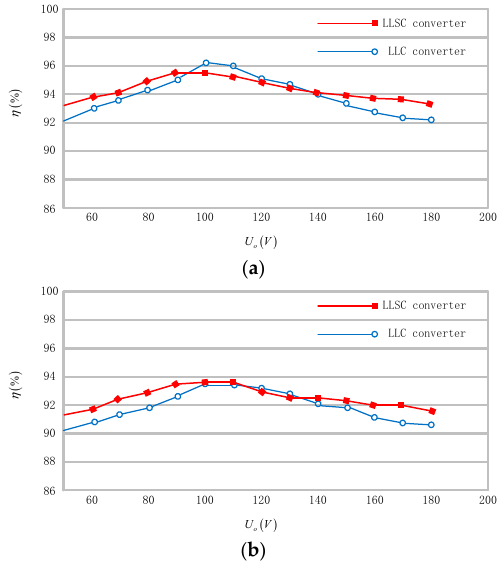
Figure 14. Efficiency comparison between the LLSC converter and LLC converter. ( a ) 100% load and ( b ) 50%